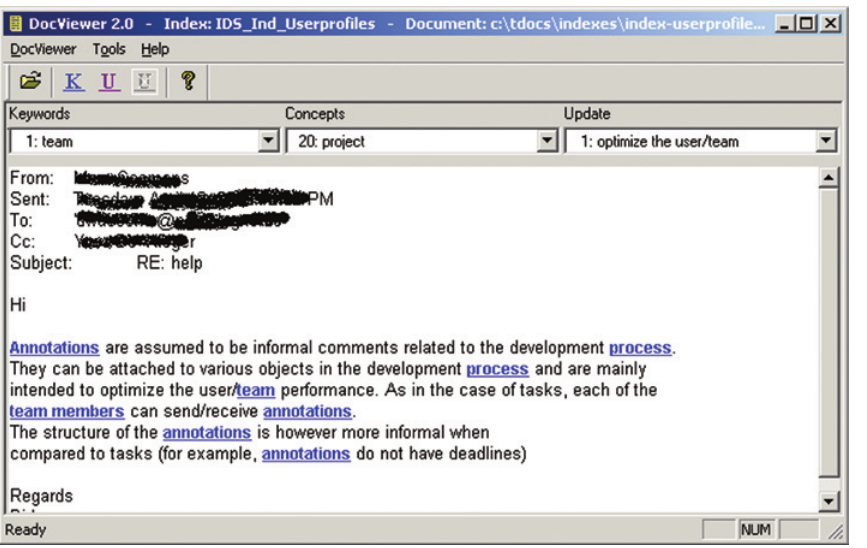
Figure 8. A Sample Message Retrieved Relevant to